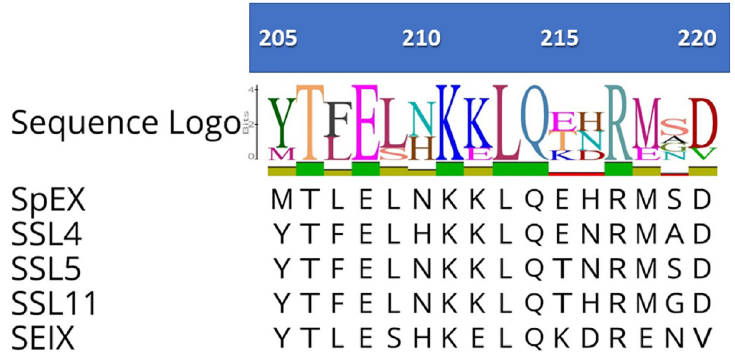
Fig 2. Multiple sequence alignment of SpEX glycan binding domain with S . aureus SSL and SEIX. Proteins with accession numbers are SSL4 (WP_000705627.1), SSL5 (WP_000784244.1), SSL11 (WP_000769163.1) and SEIX (AEI60186.1). Threonine (T) 206, serine (S) 208, lysine (K) 211, leucine (L) 213 and arginine (R) 217 are identical among all analyzed proteins (five proteins). The numbers refer to the position of the amino acids in full length SpEX protein.